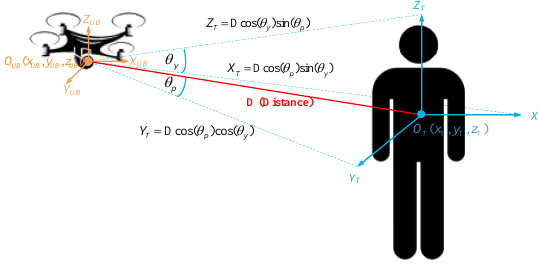
Figure 7. Coordinate transformation.